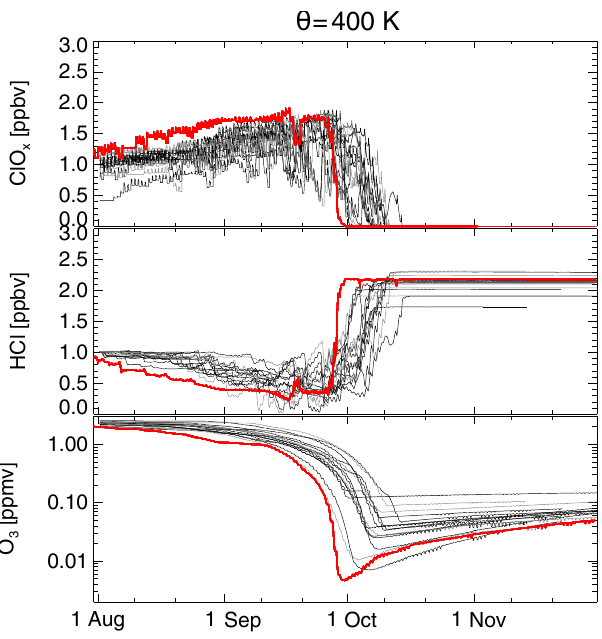
Figure 4. Results from multi-trajectory simulations of CLaMS. Box-model simulations were performed for a set of trajectories passing the South Pole at 400K taken from Grooß et al. (2011). The box-model simulations cover the time period from 1 August to 30 November 2003. A few trajectories showing very little diabatic descent (and thus much smaller values of total chlorine) were ne- glected. Initial values were chosen consistently with the reference run (Fig. 1), which is shown here in red. Individual trajectories are shown in different shades of grey to allow them to be distinguished more